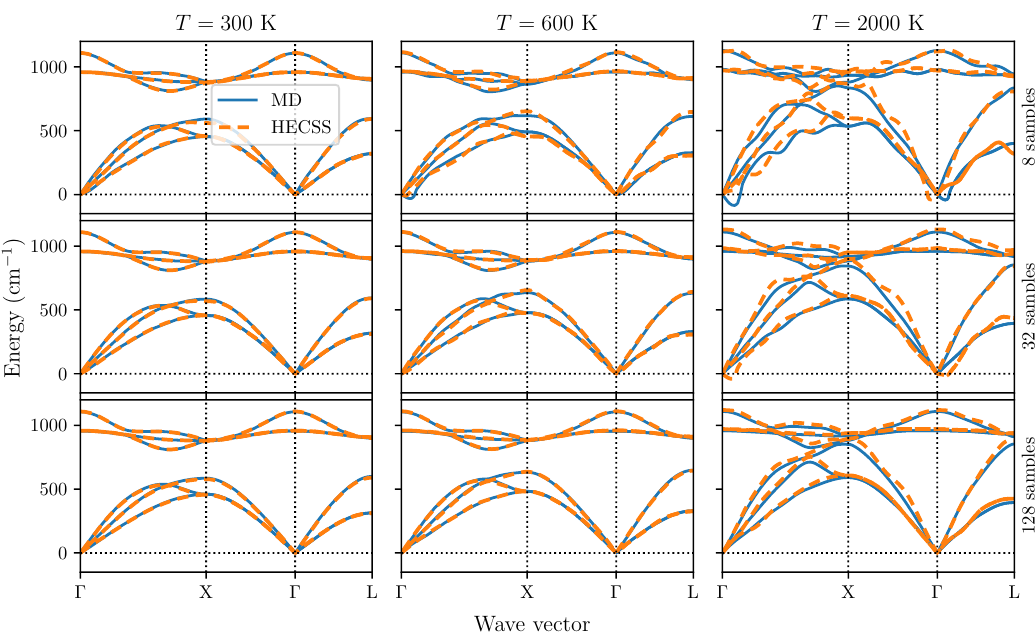
Figure 5: Consistency and convergence of phonon frequencies in 3C-SiC crystal de- termined with harmonic model derived from MD (solid lines) and HECSS (dashed lines) data. The plots correspond to the temperatures T = 300, 600 and 2000 K. The rows illustrate convergence of the result with number of samples (8, 32 and